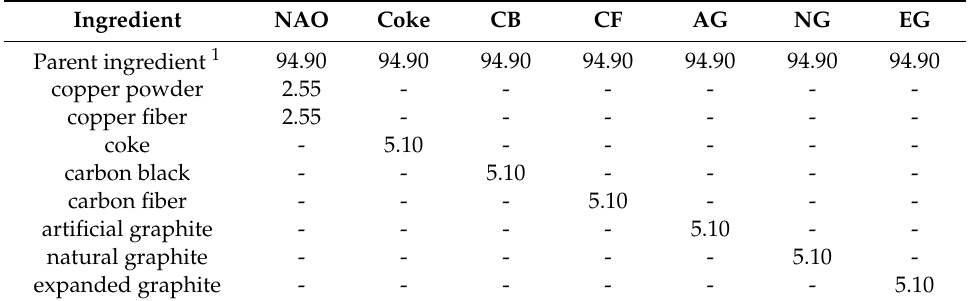
Table 2. List of copper and copper-replaced (carbonaceous) components (content in vol %).